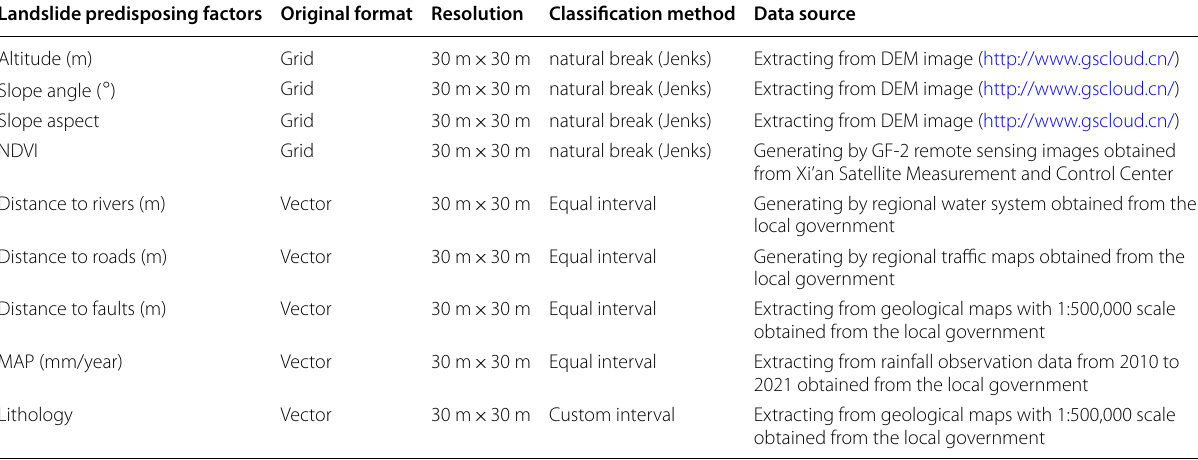
Table 2 The information and data source of landslide predisposing factors Landslide predisposing factors Original format